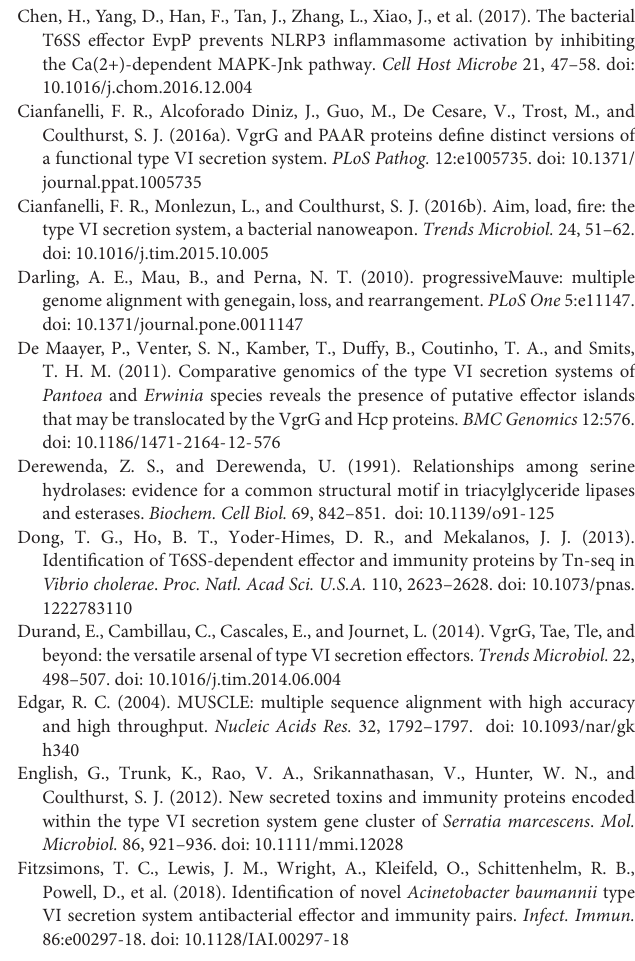
strain from where it was derived followed by an underscore then the number of the group the effector region belongs to (based on effector groups, see ML phylogenetic tree shown in Figure 2 ). (a) Fasta file of A. baumannii T6SS predicted effectors. (b) Fasta file of A. baumannii and other characterized T6SS FILE S5 | A. baumannii effector pair-wise amino acid identity matrix. Reported values are the maximum identity of the smallest protein sequence of the pair across the entire sequence length. FILE S6 | Immunity protein predicted sub-cellular